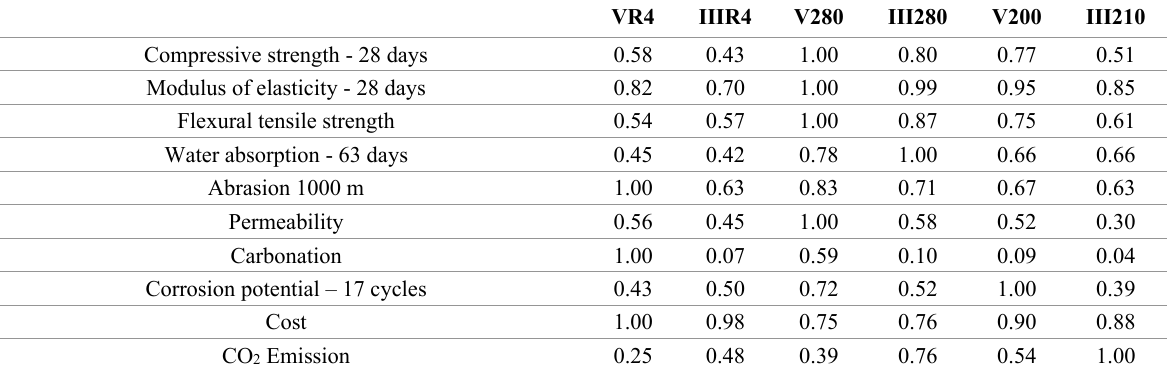
Table 7. Standardized Data.